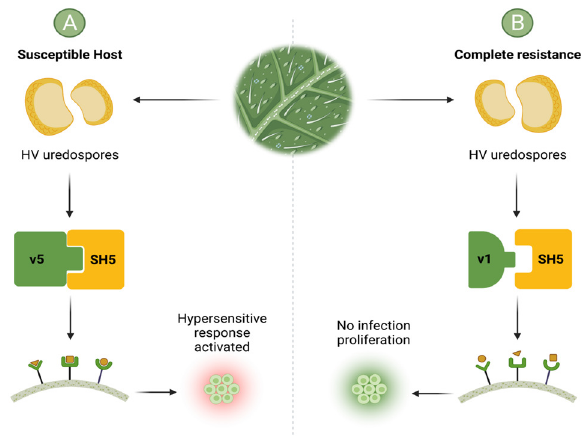
Figure 3. Development of complete resistance and susceptible phenotypes based on the interaction between the virulence genes from H. vastatrix (HV) and resistance genes from Coffea arabica . The virulence gene v5 comes from HV race II, the most common variety in Mexico. The susceptible host ( A ) is generated when a compatible Plant-Pathogen interaction occurs. In other words, because of the perfect match between the virulence gene from HV (v5) and the resistance gene from C. arabica (SH5). As a result, the pathogen elicitors activate receptors on the cell membrane in C. arabica , activating the hypersensitive response as a defense mechanism against coffee leaf rust (CLR). In contrast, complete resistance is present ( B ) because of the genetic incompatibility between the HV virulence gene (v1) and the resistance gene from C. arabica (SH5). Hence, the Plant-Pathogen interaction is not formed, and the infection does not